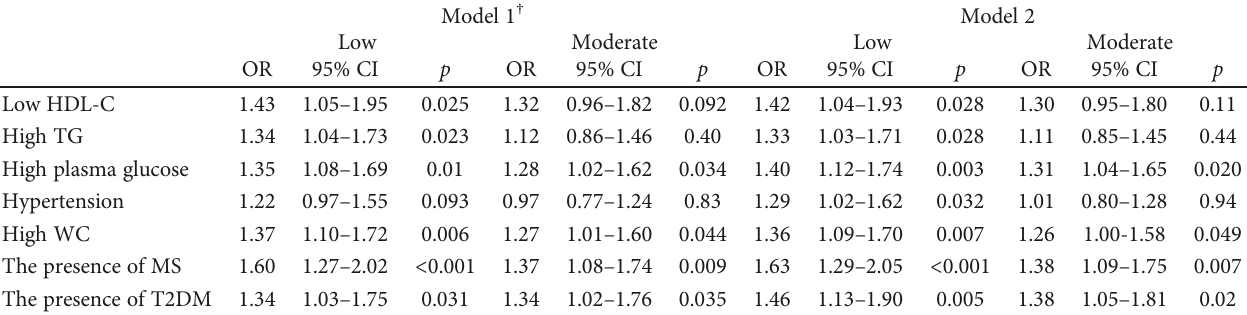
Table 5: Multivariate logistic regression for PA levels and DM and MS.